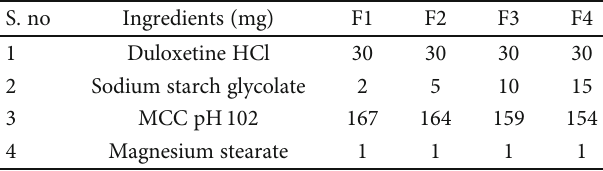
Table 1: Composition of Duloxetine HCl core